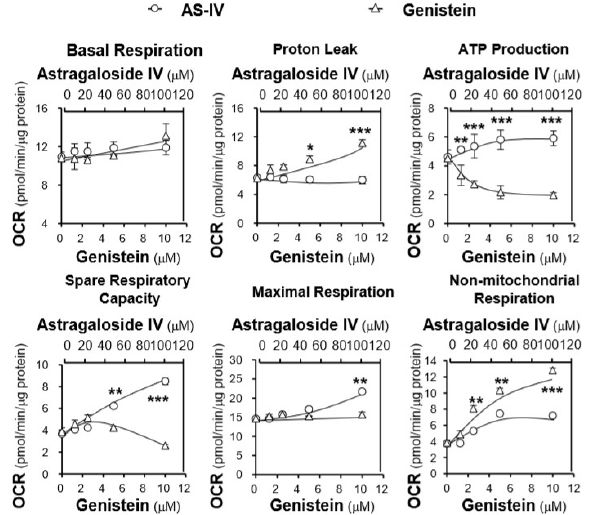
Figure 8. Mitochondrial respiration in tBHP-treated H9C2 cells after pre-treatment with astragaloside IV and genistein. Cultured H9C2 cells were treated as in Figure 7. The basal respiration, proton leak, mitochondrial ATP production, spare respiratory capacity, maximal respiration, non-mitochondrial respiration were measured. The OCR values were normalized with respect to the cellular protein content/well by the Bradford’s method. The data are expressed as mean ± SD, n = 3, each with triplicate samples. Statistical comparison was made with the sample with the lowest value of the corresponding concentration, * p < 0.05, ** p < 0.01, *** p < 0.001.